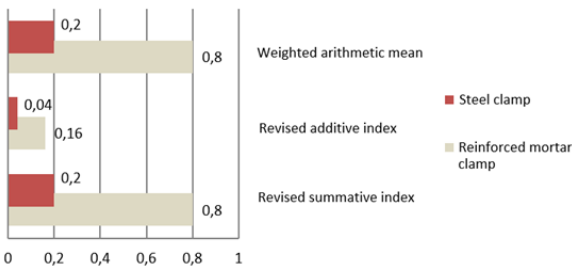
Figure 3: Comparison of synthetic measure values for encoding with the von Neumann – Morgenstern method (own studies)